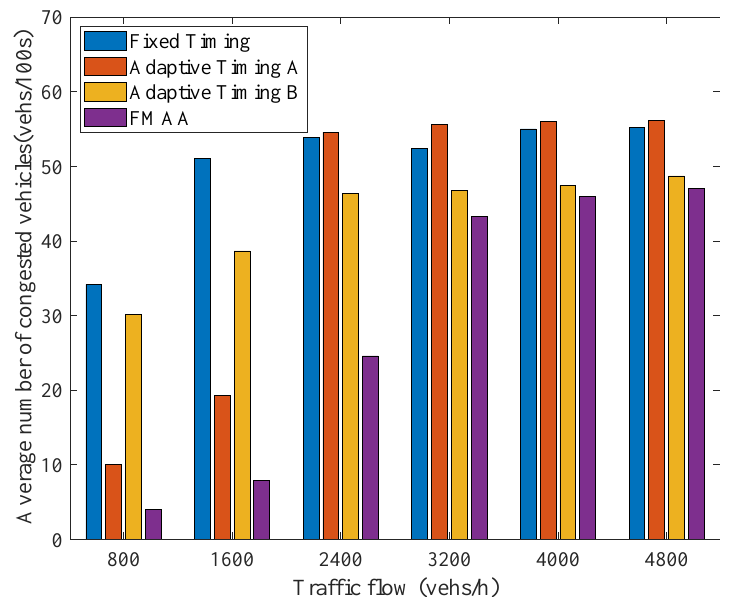
Figure 7. Average number of congested